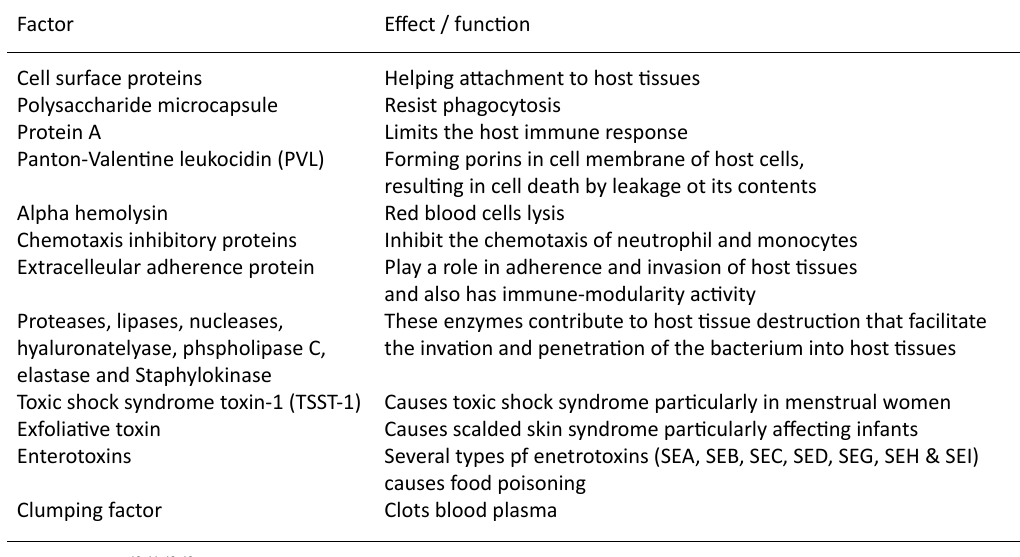
table 2. Staphylococcus aureus virulence factors